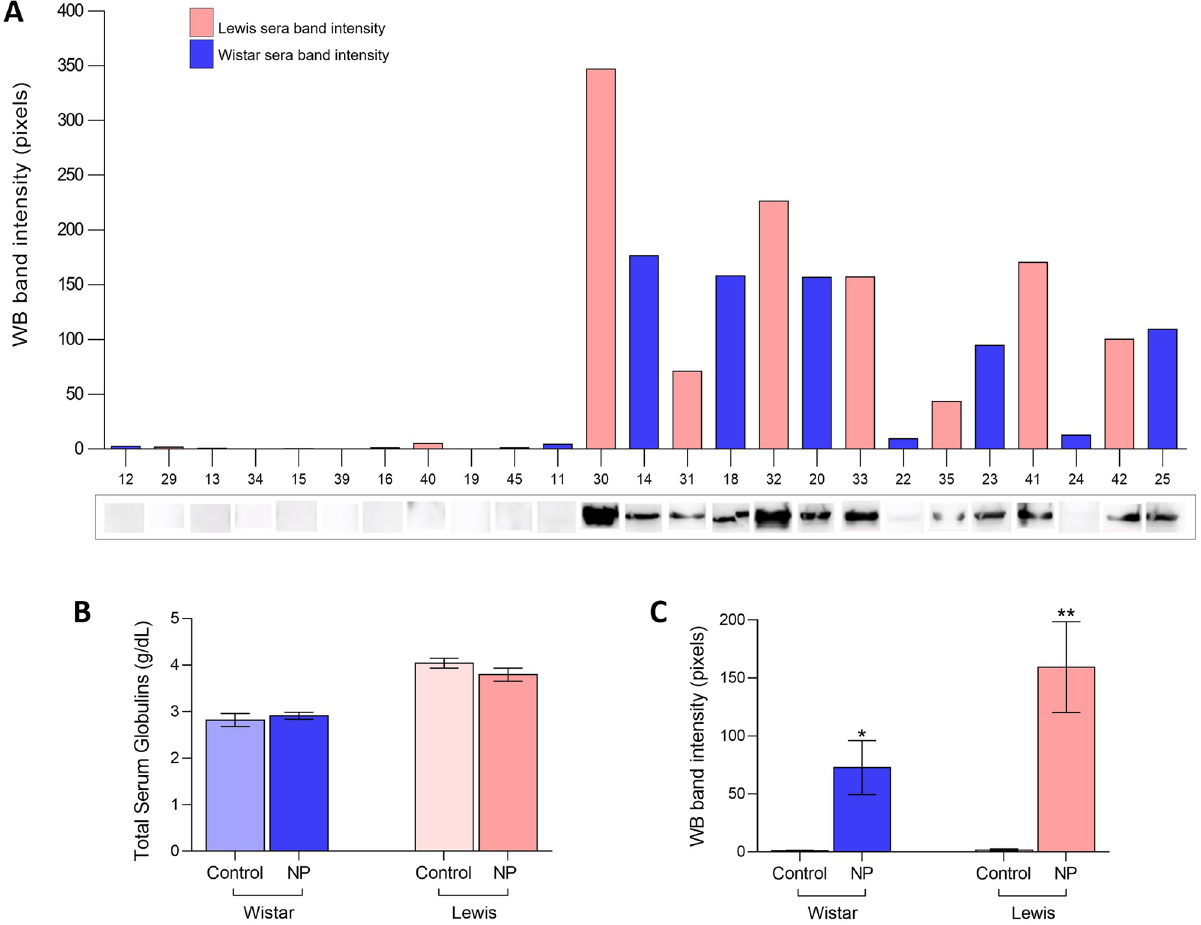
Fig 3. Immunization: A) Illustrative WB bands, pointing the presence of anti-NP specific IgG antibodies in the serum samples of both Wistar and Lewis rats submitted to NP inoculations (numerical identification of each animal is on X axis), B) Total serum globulin concentration (g/dL), C) WB band intensity